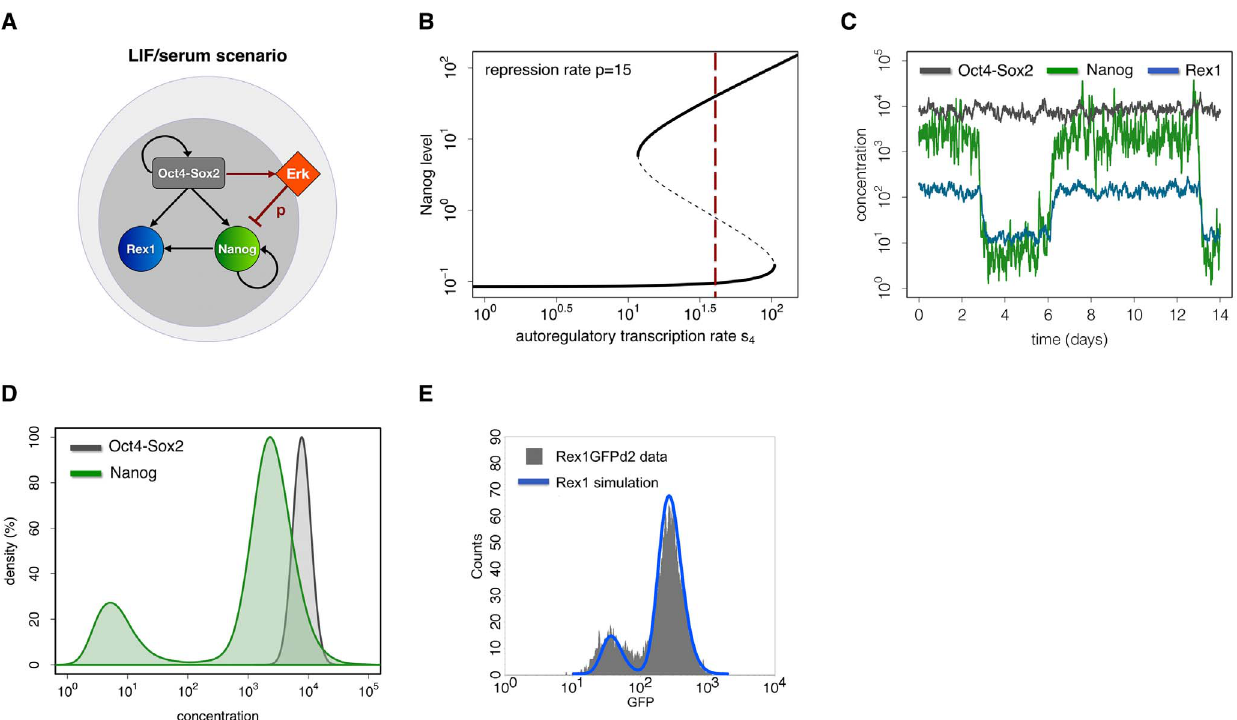
Figure 3. Mechanistic explanation and simulation results for the LIF/serum scenario. (A) Model scheme. Autocrine FGF4/Erk signalling is proposed to inhibit the transcription of Nanog at rate p. In the LIF/serum scenario Erk signalling is active (i.e. p . 0). (B) Bifurcation diagram. Assuming a constant transcription rate s4 (vertical red line) under LIF/serum mESCs are captured in a bistable region (p=15) with respect to Nanog expression. (C) Single cell trajectories. The diagram shows simulated trajectories of Oct4-Sox2 (grey), Nanog (green) and Rex1 (blue) concentrations for the LIF/ serum scenario. (D) Simulated TF distributions of Nanog (green) and Oct4-Sox2 (grey) within mESC populations at time point t=4320 min (i.e. 3 days of in silico culture). In the LIF/serum scenario Nanog is subject to state changes establishing a bimodal TF distribution. The curves are normalized to match the local maxima for high expression states under LIF/serum conditions. (E) Comparison of the simulation result for Rex1 (blue line) with experimental data (grey histogram) obtained from flow cytometry analysis of Rex1GFPd2 mESCs maintained in LIF/serum. The parameter set used for these simulations is given in Table S1 in File S1.